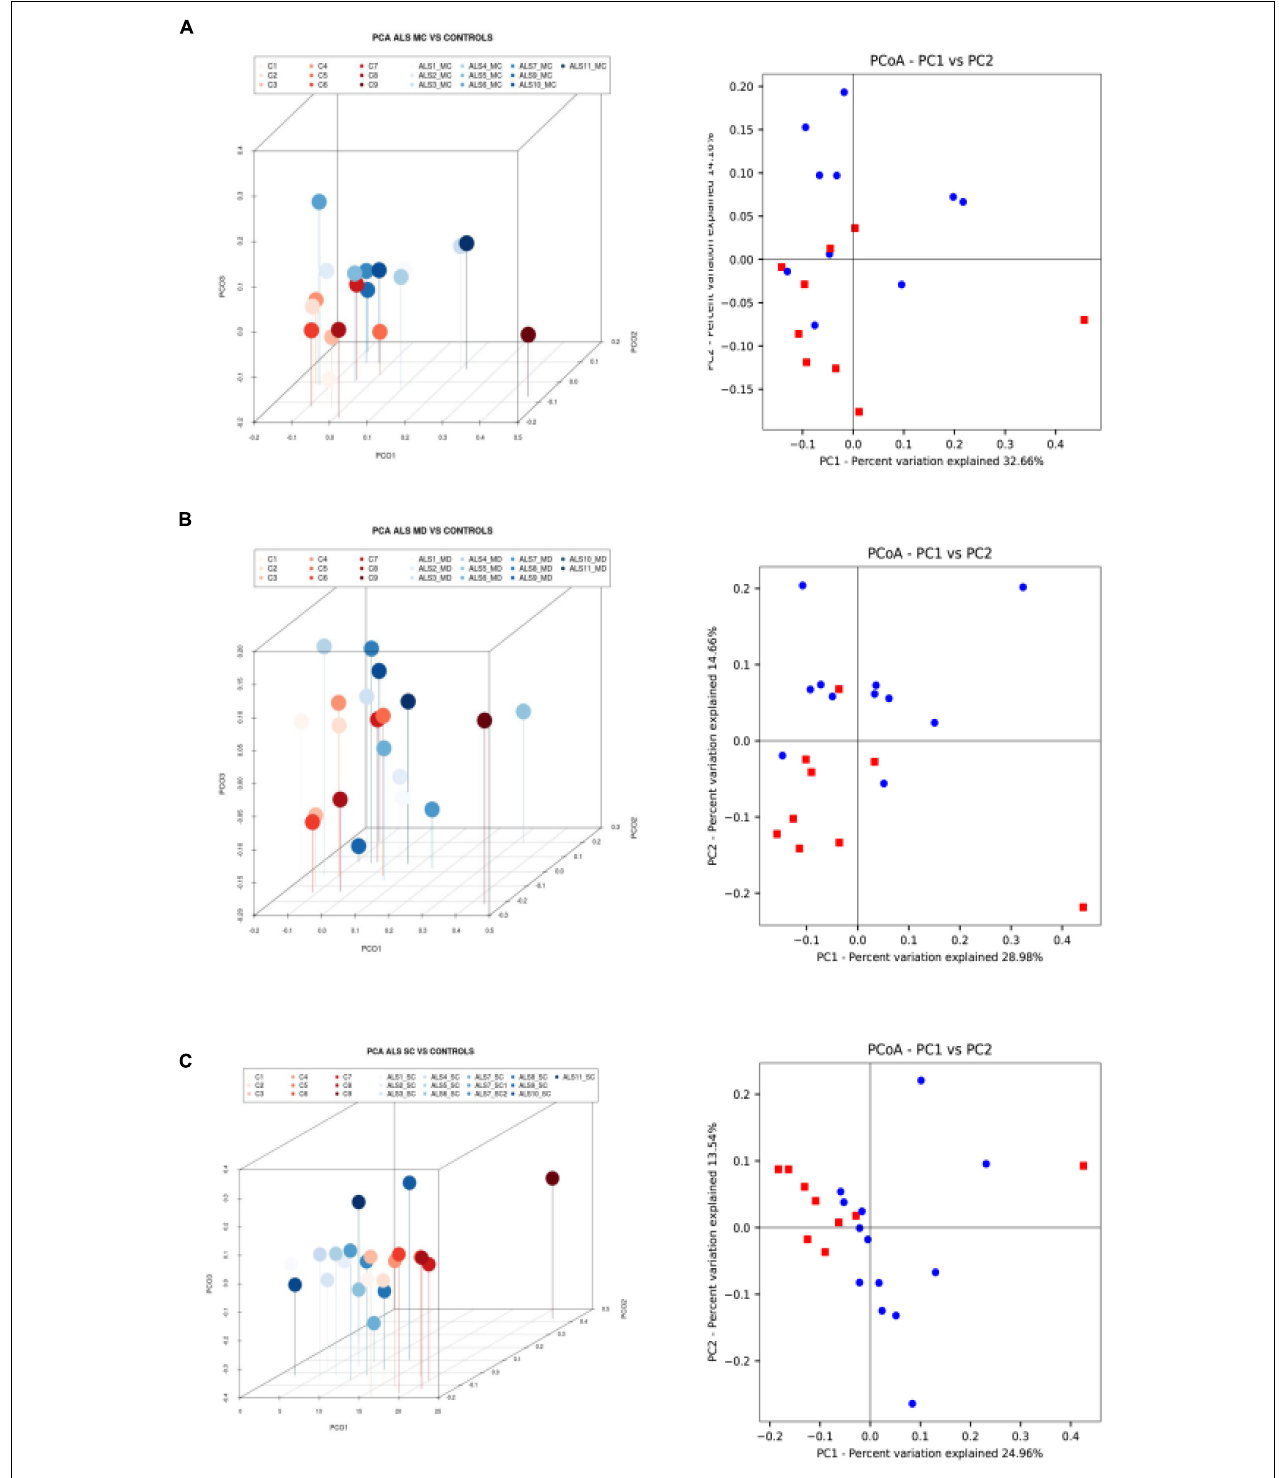
FIGURE 5 | Three- and two-dimensional principal component analysis of bacteria of CNS regions from ALS patients and control samples. (A) Left panel: three-dimensional (3D) principal component analysis (PCA) between MC regions of 10 ALS patients (plots in blue) and 9 control samples (plots in red). Right panel: 2D PCA. (B) Left panel: 3D principal component analysis between MD regions from 11 ALS patients (plots in blue) and 9 control samples (plots in red). Right panel: 2D PCA. (C) Left panel: 3D PCA between SC regions from 11 ALS patients (plots in blue) and 9 control samples (plots in red). Right panel: 2D PCA. The UniFrac method was used to calculate this parameter. MC, motor cortex; MD, medulla; SC, spinal